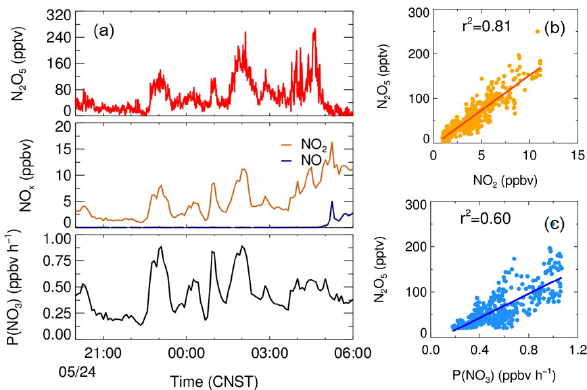
Figure 4. The correlation of the mixing ratio of N 2 O 5 and NO 2 and the production rate of NO 3 on the night of 24